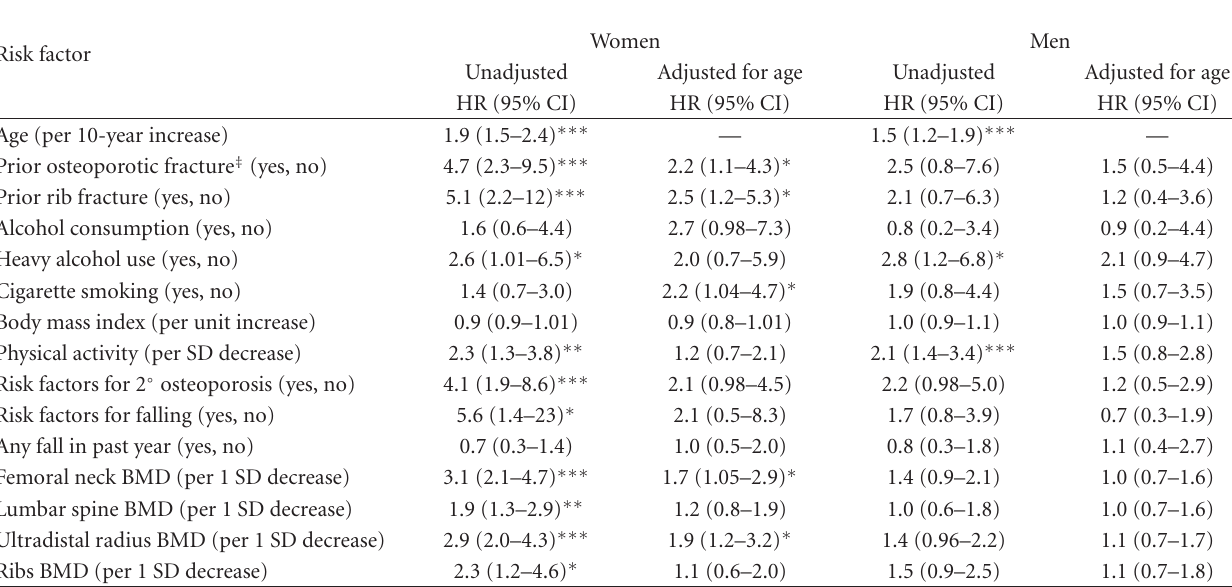
Table 2: Association of specific risk factors at baseline with subsequent rib fracture risk among 351 Rochester, Minnesota, women and 348 Rochester